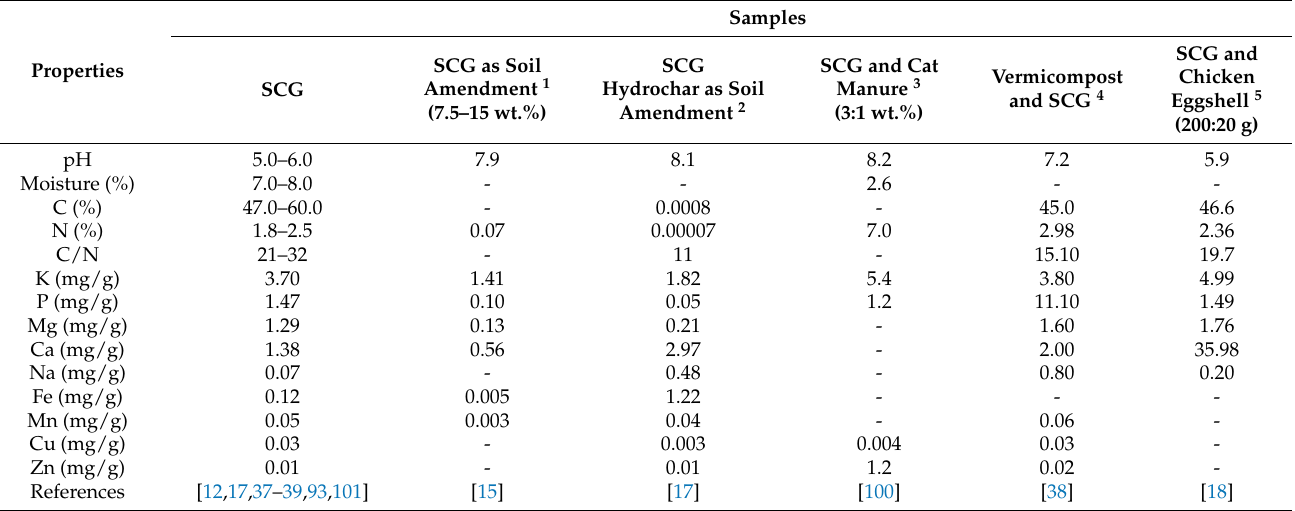
Table 2. Main physicochemical properties for SCG applications as soil amendment and